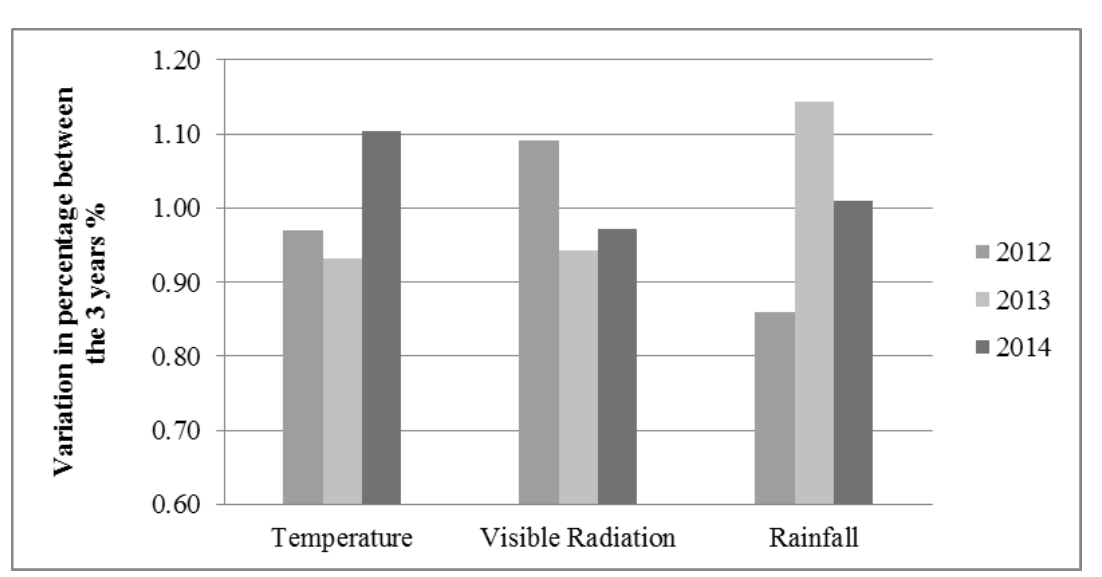
Figure 3. Variation in percentage of the averaged sum of temperature (°C), visible radiation (J·cm −1 ) and rainfall (mm) from February 1 to July 31 in the defined ESU of the study area. Values were calculated by the value of a given year divided by the average of the other two years for each